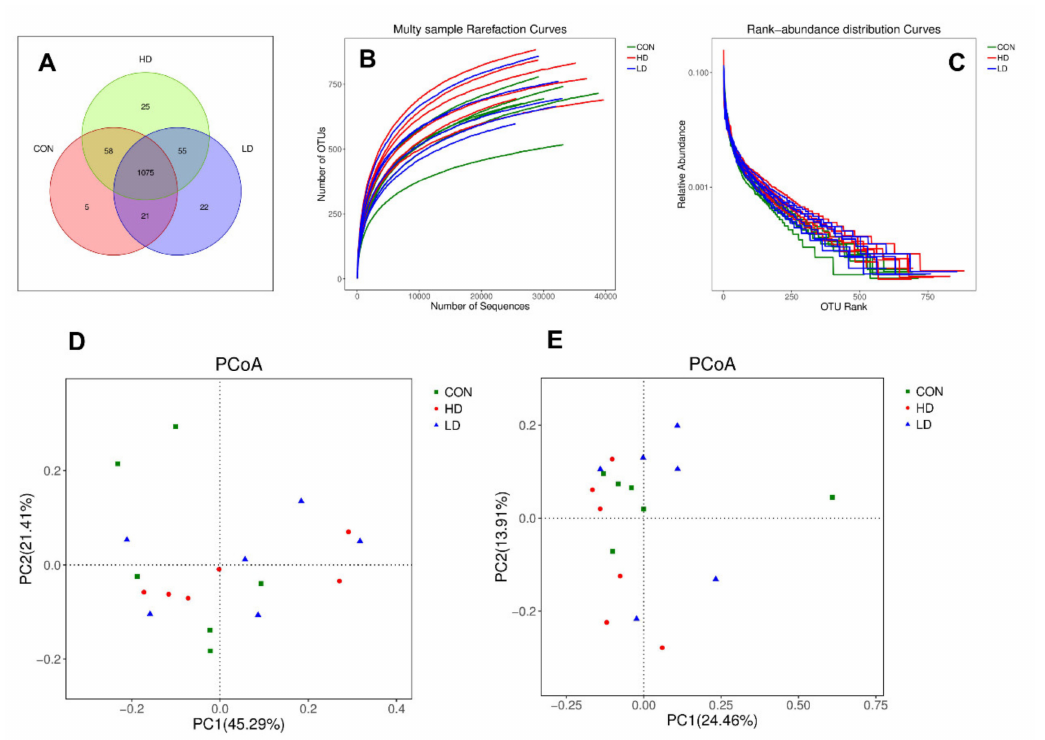
Figure 1. Rumen bacterial diversity of female goats fed varying dietary cation-anion difference. ( A ) The Venn graph. ( B ) Rarefaction curves. ( C ) Rank abundance distribution curves. ( D ) Principal coordinate analysis (PCoA) based on weighted UniFrac distance. ( E ) PCoA based on unweighted UniFrac distance.